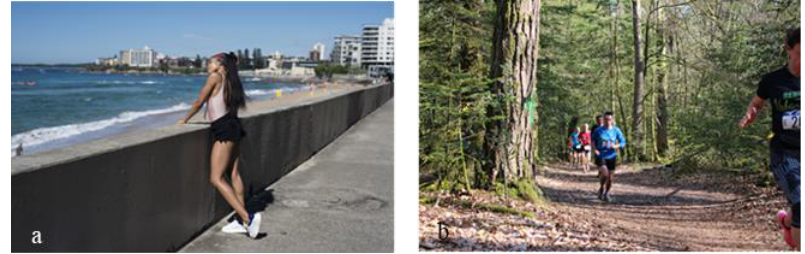
Figure 1. Examples ( a , b ) of daily life images in the DIV2K